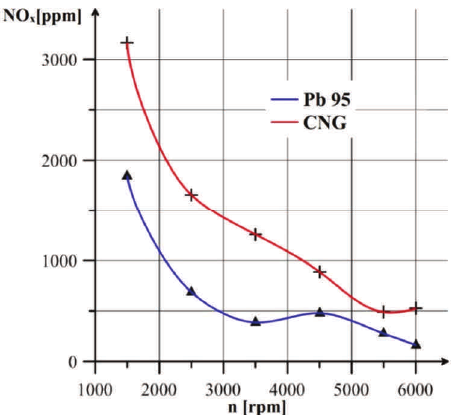
Fig. 5. Concentration of nitric oxides in the Fiat 0.9 TwinAir engine exhaust gases, working with external speed characteristics and fuelled by petrol Pb 95 and CNG